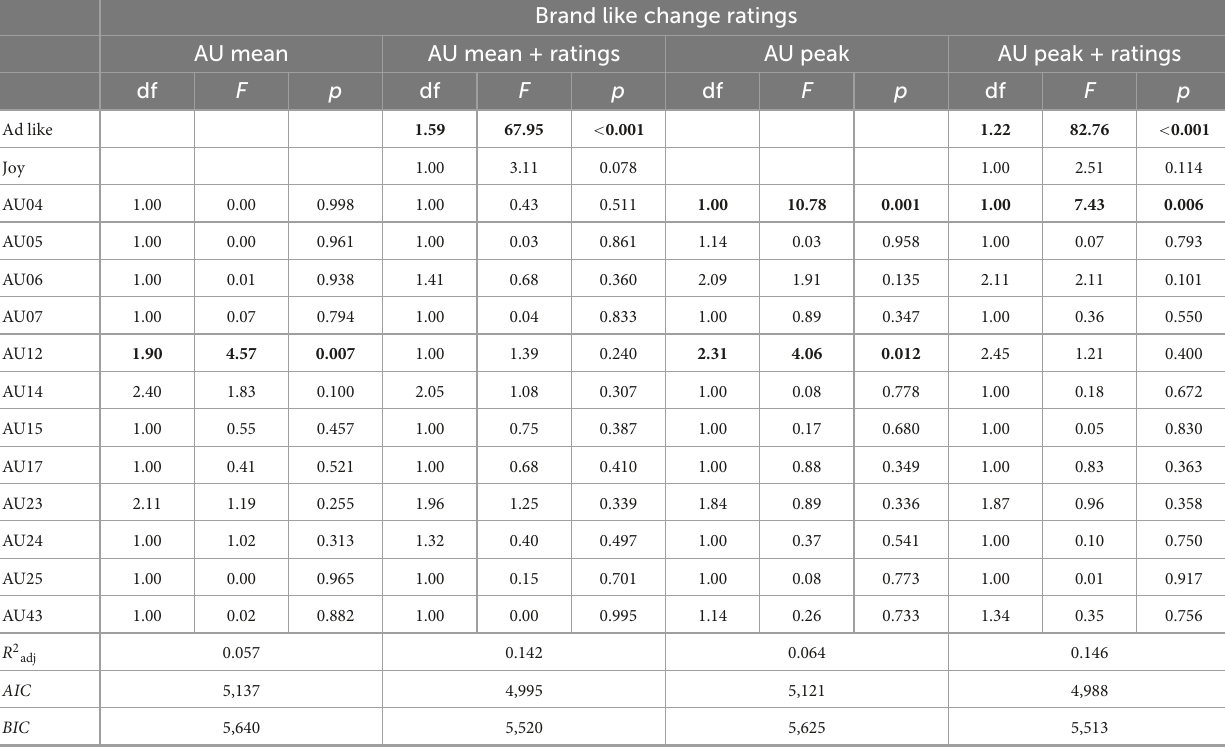
TABLE 5 Prediction of brand likeability change ratings based on mean and peak Action Unit (AU) activity with and without self-report ratings. Brand like change ratings AU mean AU mean + ratings AU